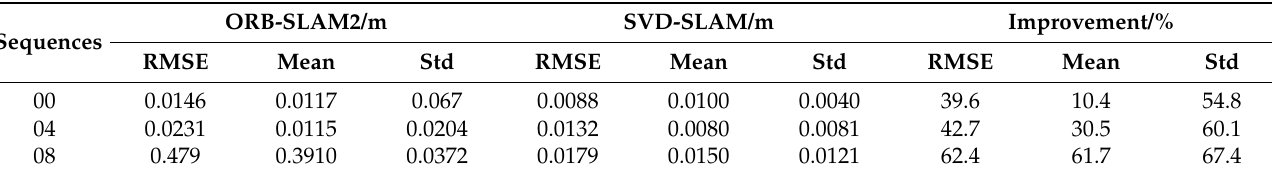
Table 3. Comparison of absolute trajectory error (ATE).